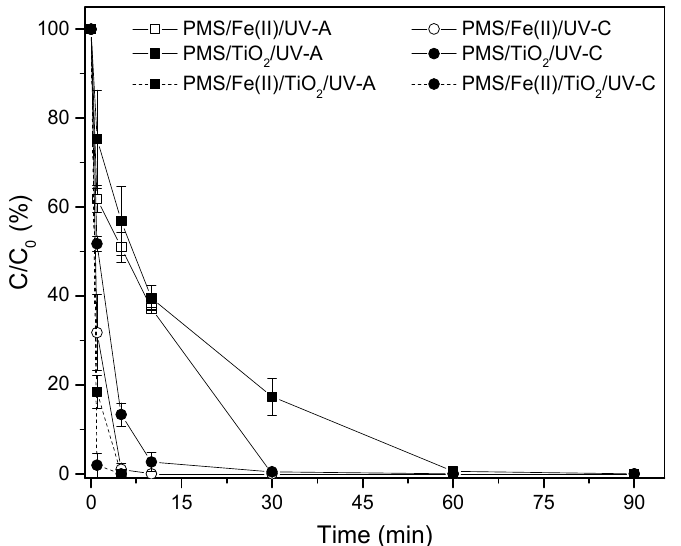
Figure 4. MB discoloration (%) through the PMS/Fe 2+ /TiO 2 system, under UV-A and UV-C radiation. [PMS] = 500 mg/L; [Fe 2+ ] = 28 mg/L; [TiO 2 ] = 500